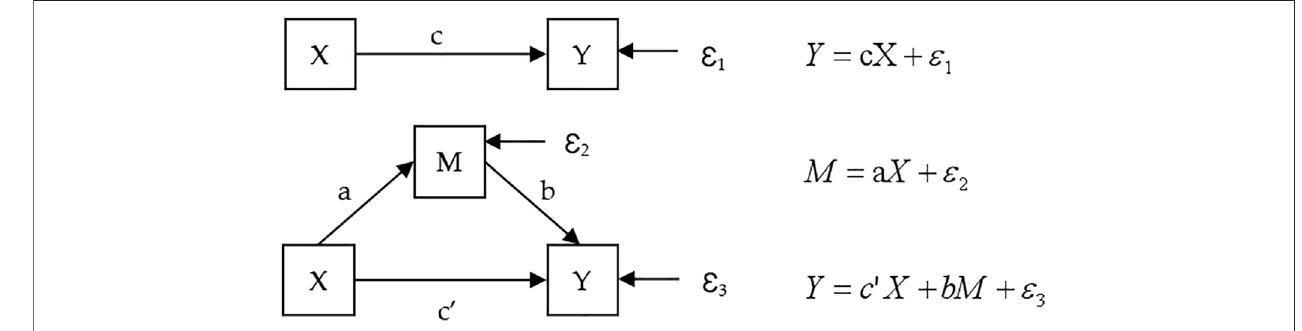
FIGURE 3 | Model of mediating effect.